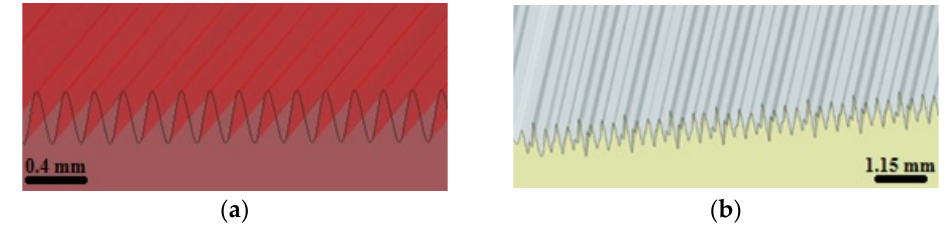
Figure 1. Visualization of produced surfaces ( a ) No. 1–3, ( b ) No. 4–6.